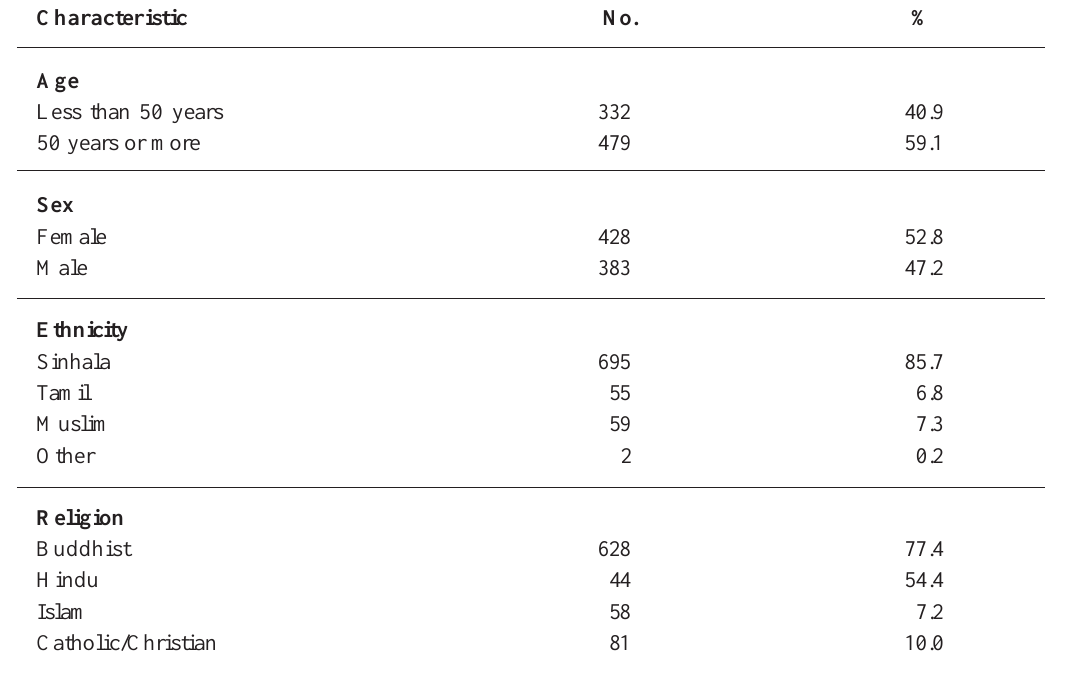
Table 2. Socio-demographic characteristics of the study population (N=811)